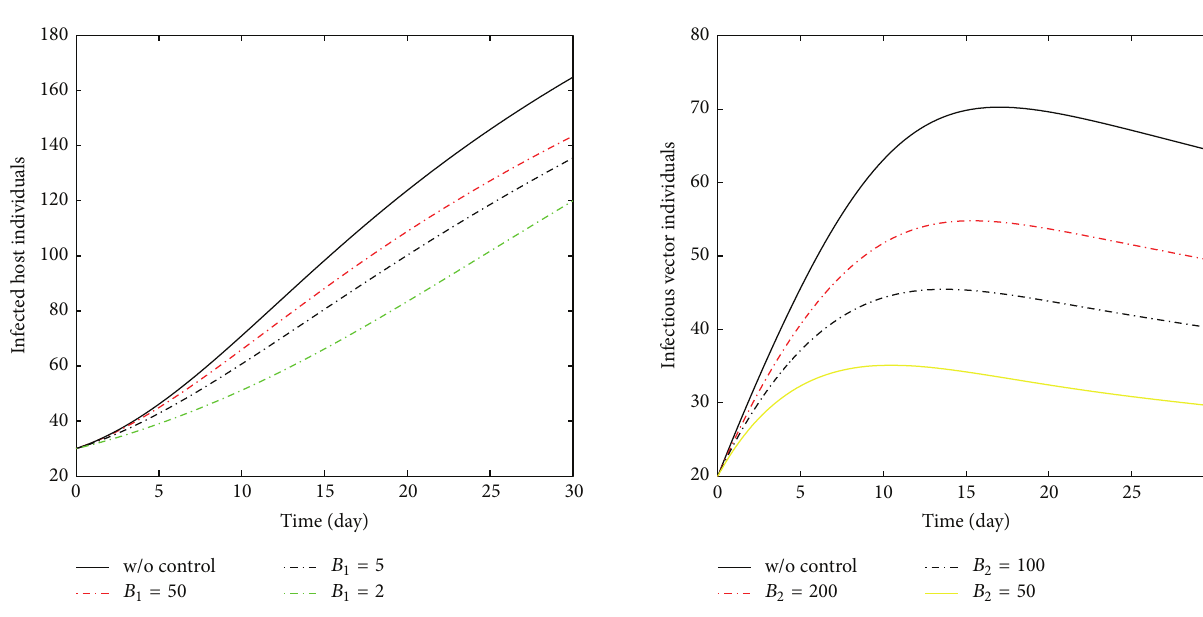
Figure 17: Plot of the number of different weight constants on the control (without control, 𝐵 2 = 200 , 𝐵 2 = 100 , and 𝐵 2 = 50